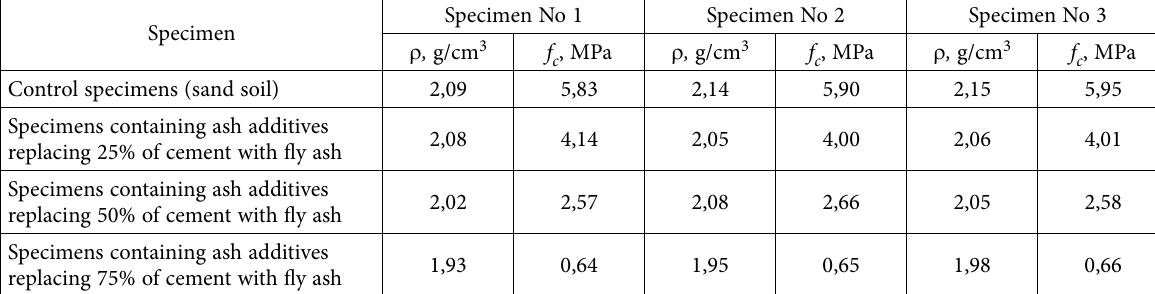
Table 2. The results of experiments on soilcrete containing fly ash additives in clay sand following 7 days of hardening Specimen No 1 Specimen No 2 Specimen No 3 Specimen ρ , g/cm 3 f , MPa ρ , g/cm 3 f , MPa ρ , g/cm 3 f , MPa c c c Control specimens (sand soil) 2,09 5,95 Specimens containing ash additives 2,08 4,01 replacing 25% of cement with fly ash Specimens containing ash additives 2,02 2,57 2,58 replacing 50% of cement with fly ash Specimens containing ash additives 1,93 replacing 75% of cement with fly ash